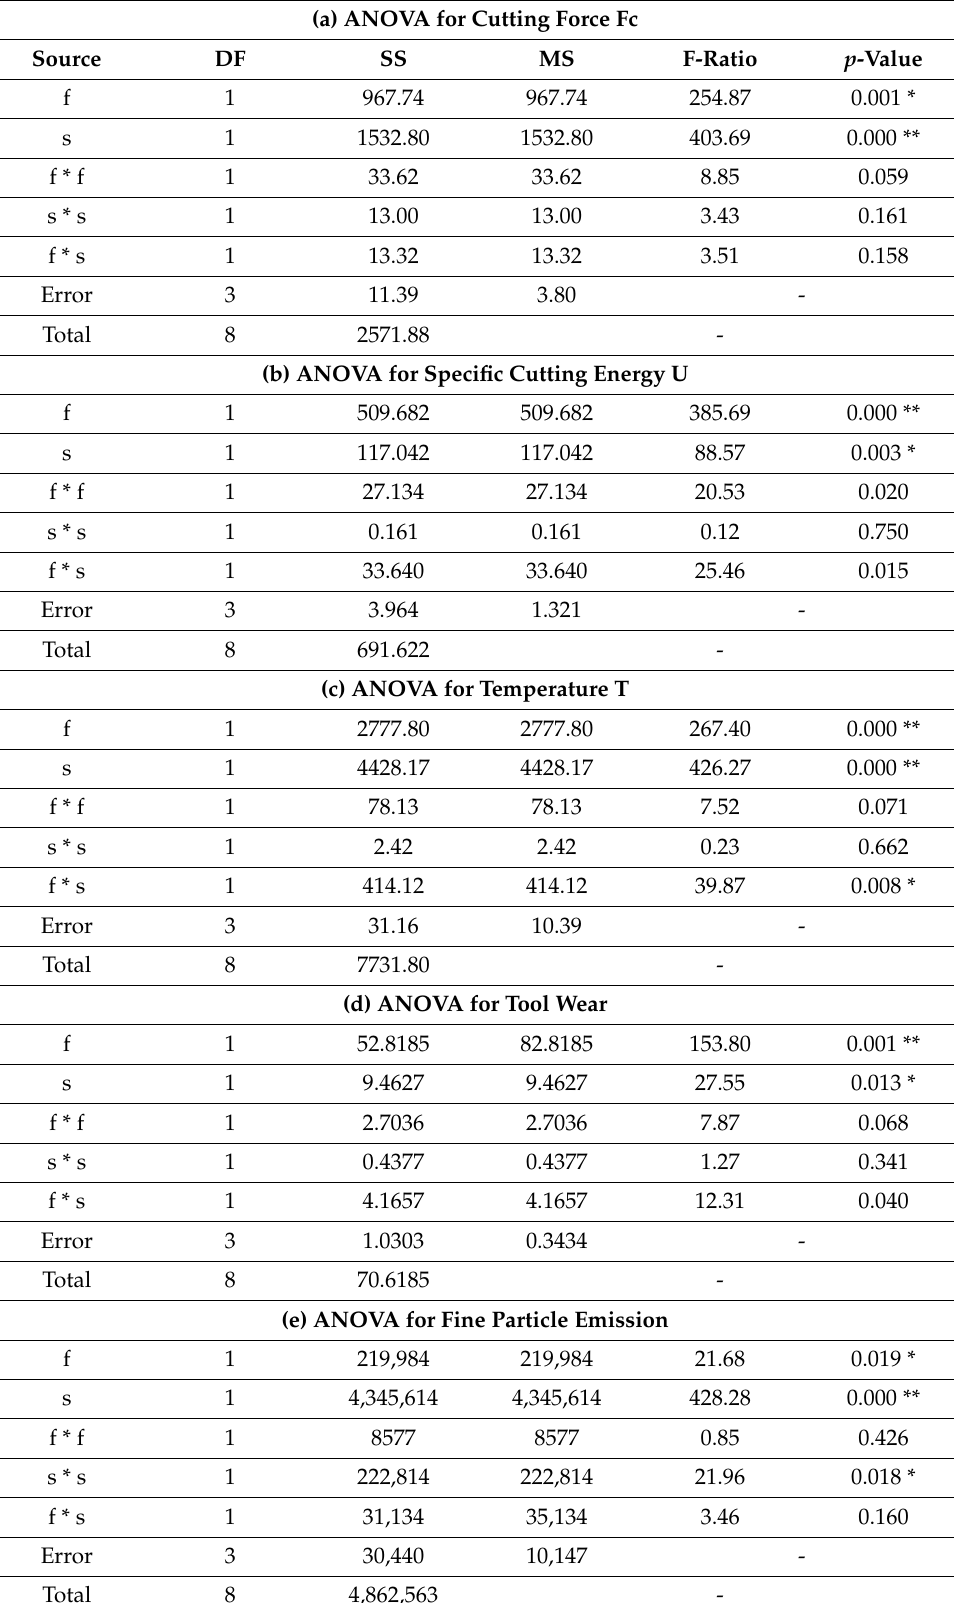
Table 5. Analysis of variance (ANOVA) for output